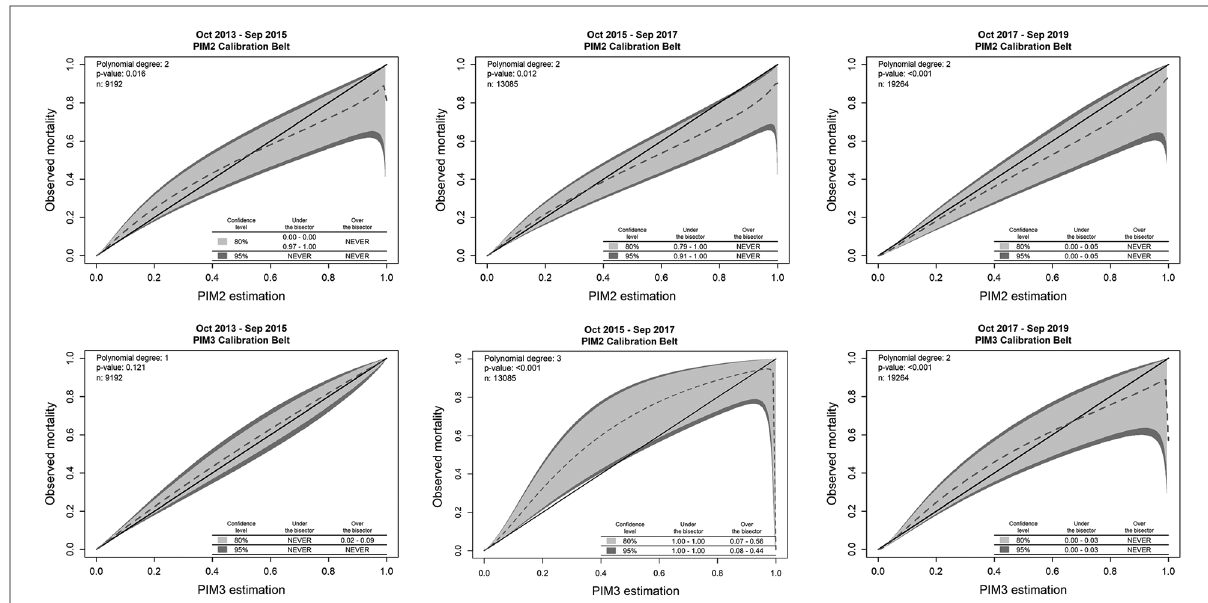
FIGURE 5 Calibration belts for PIM2 and PIM3 in the three periods from October 2013 to September 2019. PIM2 maintained a good calibration for most risk ranges in all three periods, never underestimating mortality, overestimating it in the second period in the range of more than 91% risk of death and in the third period in the range of 0 to 5% risk of mortality. PIM3, on the other hand, had excellent calibration in the fi rst two years, underestimated mortality in the risk-of-death range of 8% – 44% in the second period, and overestimated it in a small range of 0% – 3% risk mortality in the last two